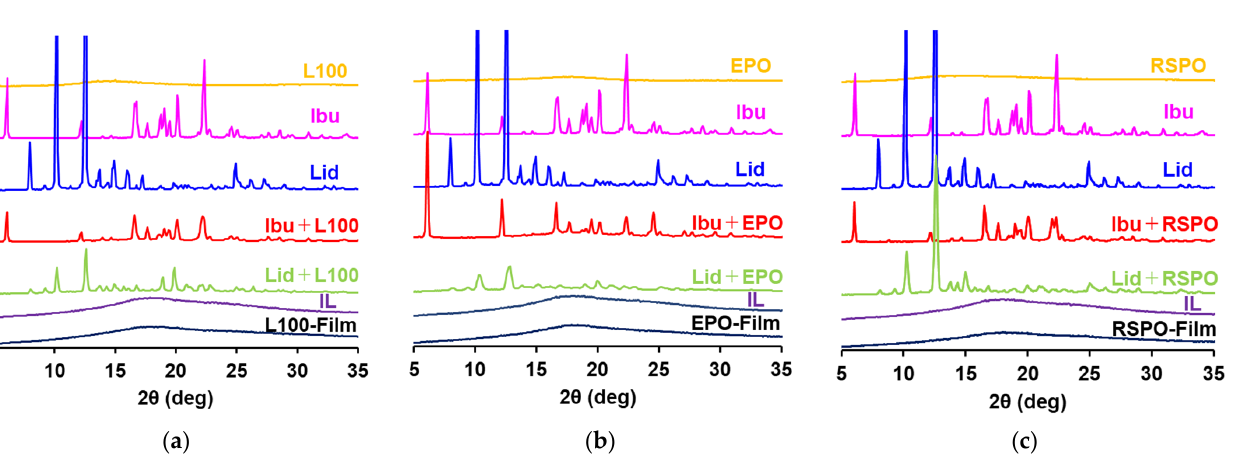
Figure 4. XRD analysis of the components of printer ink, the combination of drug and Eudragit polymers, ILs, and IL-loaded films. ( a ) XRD analysis of L100-containing samples. ( b ) XRD analysis of EPO-containing samples. ( c ) XRD analysis of RSPO-containing samples.